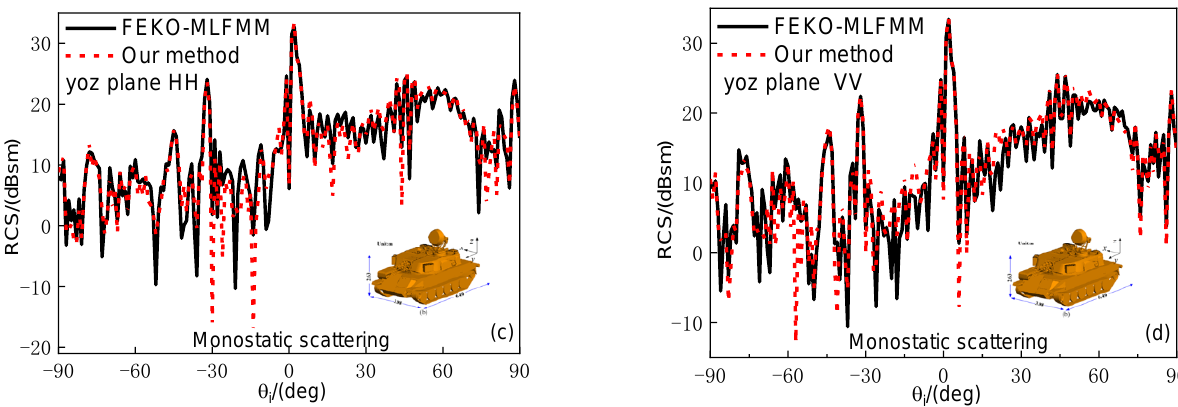
Figure 9. Bistatic and monostatic scattering of ZSU-234 antiaircraft gun using our method and MLFMM: ( a ) bistatic θ i = 10 ◦ ; ( b ) bistatic θ i = 60 ◦ ; ( c ) monostatic HH; ( d ) monostatic VV. Figures 7 and 9 present the scattering of the CCM and the ZSU-234 antiaircraft gun. The results of our method are compared with those of FEKO-MLFMM. The mean absolute error µ and its standard deviation δ are calculated and presented in Table 2. In statistics,